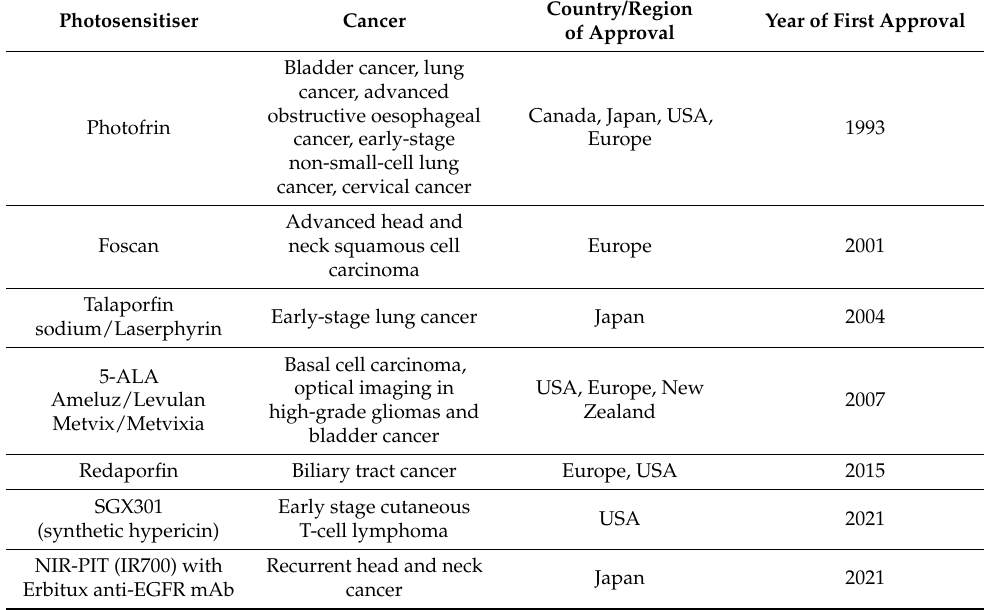
Figure 1. Schematic of photodynamic therapy. When light of a particular wavelength interacts with the PS, the PS goes from a ground singlet state to an excited singlet state. Thereafter, intersystem crossing occurs, and the PS enters an excited triplet state. It then interacts with (1) O 2 to form 1 O 2 and (2) biomolecules to form ROS. Some excited singlet state PS molecules will return to their ground state, releasing fluorescence; others will return from the excited triplet state to the ground state, releasing phosphorescence. Table 1. List of approved photosensitisers for cancer management [32 – 34.]